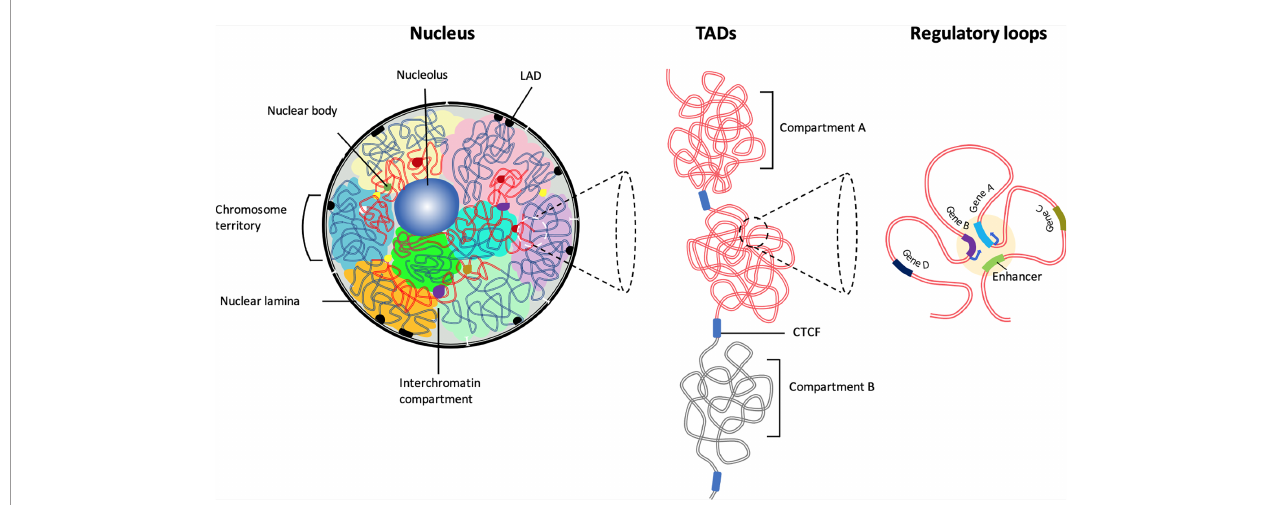
FIGURE 1 | The hierarchical organization of the 3D chromatin. Inside the interphase nucleus, chromosomes occupy distinct territories (highlighted by different colors). Within each chromosome territory the chromatin is folded into multiple loops and segregated into two distinct compartments: compartment A clustered around nucleolus and nuclear bodies (permissive region, red lines), and compartment B (repressive region, blue lines) associated with LADs at the nuclear periphery. Chromatin interactions occur predominantly between the compartments with similar biochemical or functional properties. Majority of the chromatin interactions are intra-chromosomal. The permissive chromatin regions tend to position away from the nuclear lamina or from pericentromeric heterochromatin. Preferential self- interactions within the heterochromatin and euchromatin (A and B compartments) regions result in the formation of topologically associating domains (TADs), demarcated by boundary elements enriched with CTCF/Cohesin. Within TADs chromatin undergo multiple folds to form ‘ regulatory loops ’ that facilitate close proximity interactions between gene promoters and their cognate